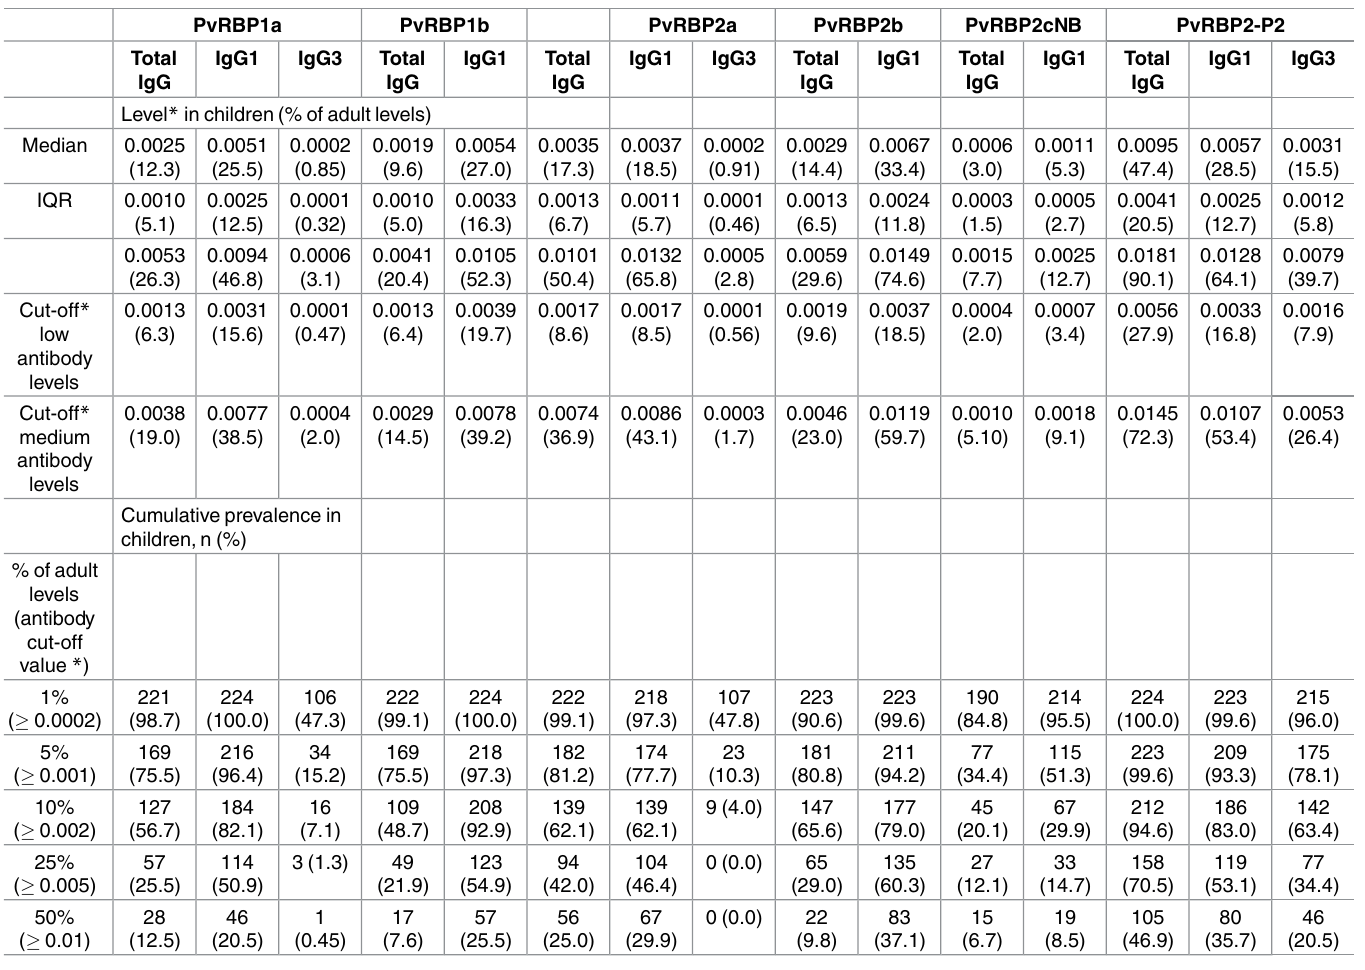
Table 1. Total and IgG subclass reactivityto PvRBPs in young Papua New